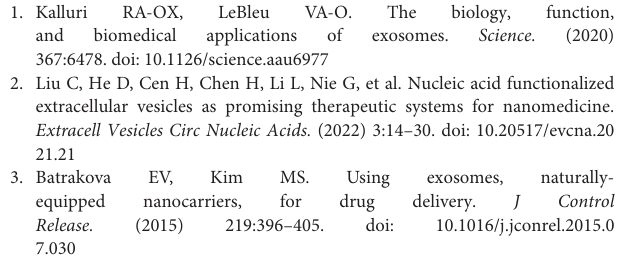
Supplementary Figure S1 | Original images for Figure 2E . Supplementary Figure S2 | Assay via Ultra Performance Liquid Chromatography (UPLC) of the encapsulation of cisplatin by milk-exosomes. (A) Representative figure of UPLC analysis of cisplatin in milk-exosome/cis. (B) Representative figure of UPLC analysis of cisplatin in blank control. Supplementary Figure S3 | Analysis of the influence of hCtr1 inhibitor, unlabelled milk-exosomes and temperature upon inhibiting pkh67 labeled milk-exosome/cis internalization via confocal microscopy. (A) Pkh67 labeled milk-exosome/cis uptake by A2780CP cells pretreated with hCtr1 inhibitor copper sulfate, unlabelled milk-exosomes and 4 ◦ C. (B) Quantification of pkh67 labeled milk-exosome/cis (green spots) uptake by A2780CP cells (blue fluorescence DAPI labeled nuclei) pretreated in different circumstances by confocal microscopy. Values represent mean ± S.E.M. ∗∗∗ , P < 0.001, ∗∗∗∗ , P < 0.0001. Supplementary Figure S4 | Original images for Figure 7A . Supplementary Video S1 | Re-constructed 3D analysis of cisplatin distribution when delivered with milk-exosomes/cis. Re-constructed 3D video of cis-FITC distribution in A2780CP cells with milk-exosome/cis delivery. Red represents endosomes, green represents cis-FITC, and blue represents DAPI stained nuclei. Supplementary Video S2 | Re-constructed 3D analysis of cisplatin distribution when delivered without milk-exosomes. Re-constructed 3D video of cis-FITC distribution in A2780CP cells without milk-exosome delivery. Red represents endosomes, green represents cis-FITC, and blue represents DAPI stained nuclei. Supplementary Table S1 | siRNA sequence. Supplementary Table S2 | Characteristics and loading abilities of exosome and exosome/cis. Supplementary Table S3 | Calculated Mander’s Colocalization Coefficient (M) and the Pearson Correlation Coefficient in Figure 8